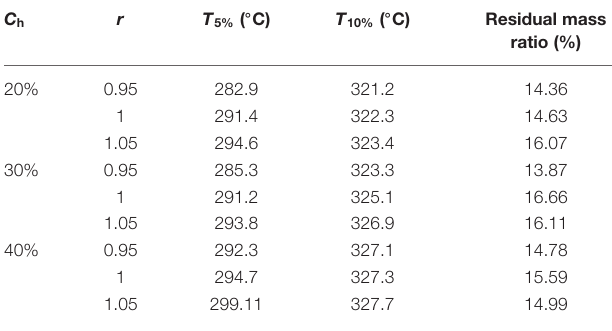
TABLE 10 | T 5 % and T 10 % of polyether-based TPU-modified asphalt.